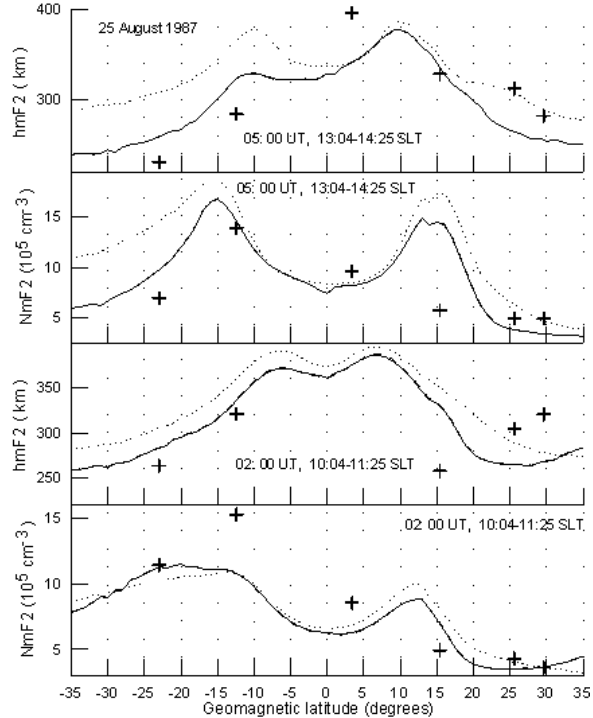
Fig. 12. Observed (crosses) and calculated (lines) hmF 2 and NmF 2 at 02:00 UT (two lower panels) and 05:00 UT (two upper panels) on 25 August 1987. The measured hmF 2 and NmF 2 are taken from the ionospheric sounder station listed in Table 1. The solid curves are the same as in Fig. 4. The dotted lines show the re- sults produced by the model, using the combinations of E eff on the corrected zonal electric field, given by crosses in Fig. 1 (as for the solid lines in Fig. 12), zero neutral wind, and the NRLMSISE- 00 neutral densities and temperature with the same corrections of [O] and T n as for the solid lines in Fig. 12. The dashed lines show the results produced by the model, using the combinations of E eff based on the zonal electric field, given by the dashed lines in Fig. 1, and the HWW90 wind velocities, the NRLMSISE-00 neutral den- sities and temperature with the same corrections of W, [O], [N 2 ], [O 2 ], and T n as for the solid lines in Fig.